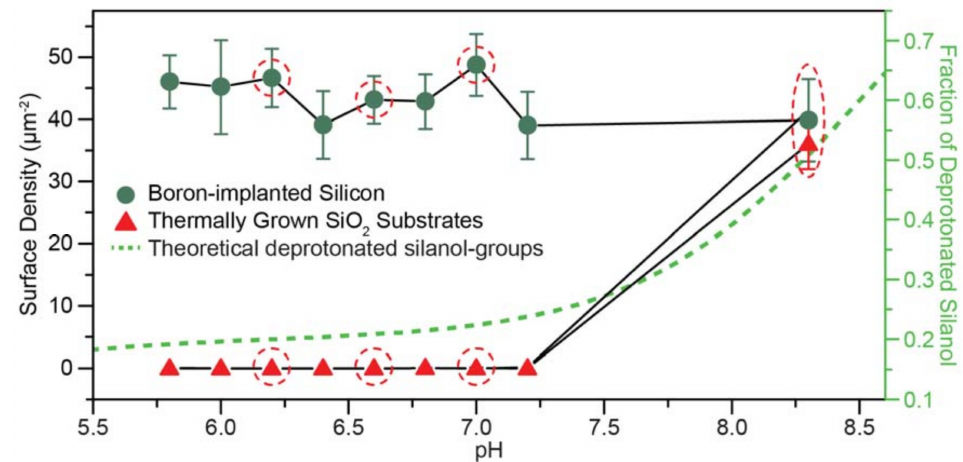
Figure 5. DNA origami surface density on boron-implanted silicon substrates oxide (green circle) and thermally grown SiO 2 substrates (red triangle) as a function of deposition buffer pH. Representative data points for the AFM images in Figure 3 are highlighted with red circles, and the theoretical population fraction of deprotonated silanol-groups on the oxide surfaces is depicted with a green dotted